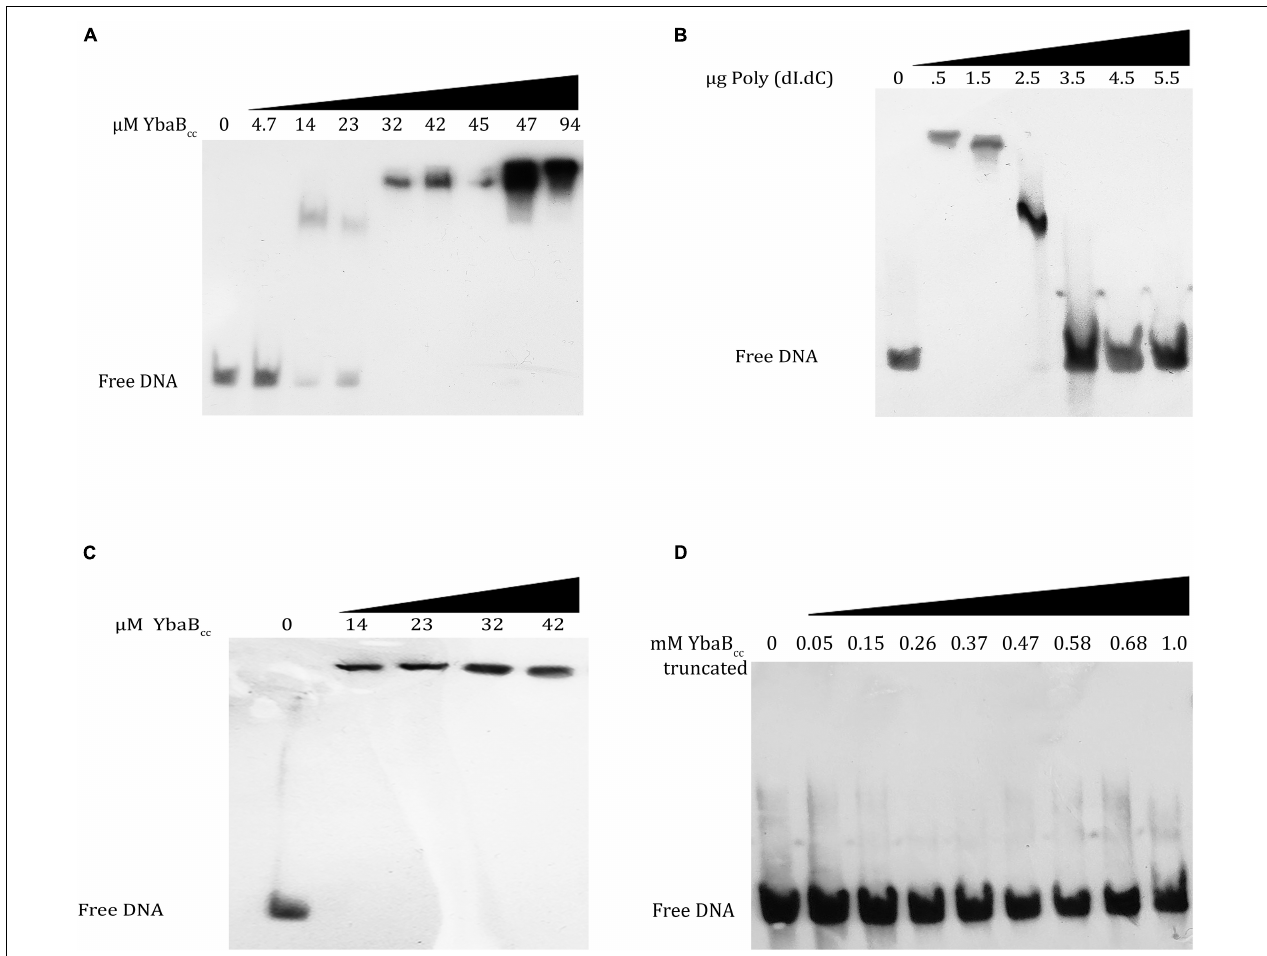
FIGURE 4 | YbaB Cc binds to DNA in a sequence-independent manner in vitro . YbaB Cc was incubated with 8 nM each of biotin-labeled probes. (A) b-WT (124 bp) from Borrelia burgdorferi strain B31 was incubated with increasing concentrations (0, 4.7, 14, 23, 32, 42, 45, 47, and 94 µ M) of YbaB Cc protein. (C) cc-WT (200 bp) Caulobacter probe was incubated with increasing concentrations (0, 14, 23, 32, and 42 µ M) of YbaB Cc protein. Reactions were electrophoresed on 6% DNA retardation gels and visualized by chemiluminescent detection. YbaB Cc forms DNA–protein complexes with both probes (A–C) causing shifts of protein–DNA complexes. (B) Competitive binding was also studied by adding varied concentrations (0, 0.5, 1.5, 2.5, 3.5, 4.5, and 5.5 µ g) of Poly (dI.dC) to YbaB Cc (32 µ M). The presence of free DNA with increasing Poly (dI.dC) indicates sequence independent DNA-binding activity of YbaB Cc by exchange of b-WT (124 bp) from Borrelia burgdorferi strainB31 probe with Poly (dI.dC). (D) YbaB Cc (Tn) protein (containing only N-terminal DNA-binding domain) was also tested for its ability to bind b-WT Borrelia probe. However, there was no shift observed even at very high protein concentrations rendering this truncated version of YbaB Cc to be ineffective in DNA-binding suggesting that both DNA-binding domains are essential for YbaB Cc protein to bind target DNA.